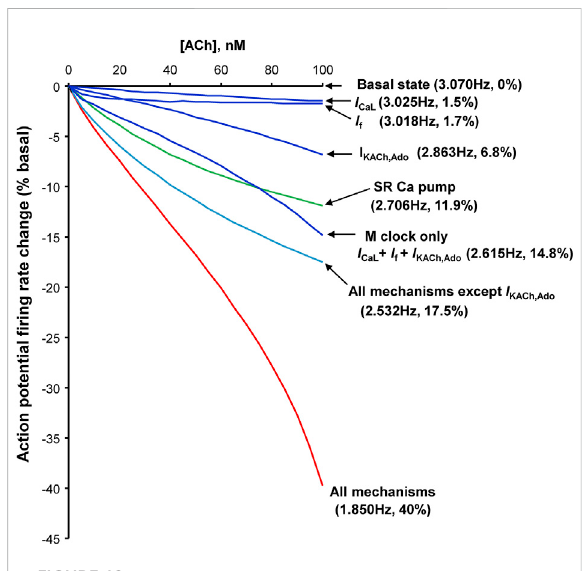
FIGURE 12 Synergism of different component mechanisms in SANC rate slowing by ACh. Results of numerical model predictions for spontaneous AP rate reduction at various moderate ACh concentrations (up to 100 nM) for different mechanisms (labels). Since ACh and ado act via the same signaling mechanism, a similar result is expected for ado. Modi fi ed from (Maltsev and Lakatta,